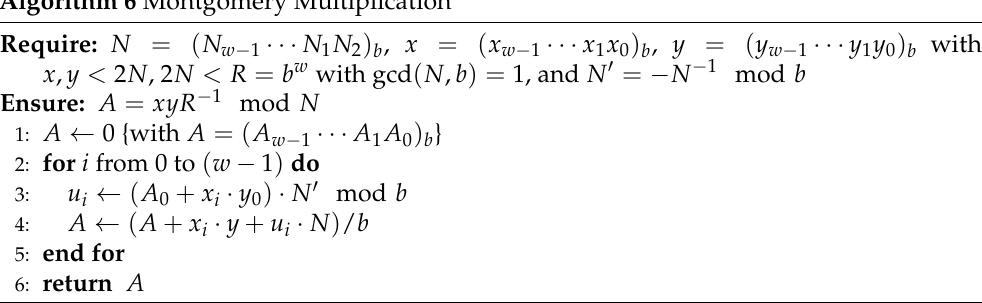
Algorithm 6 Montgomery